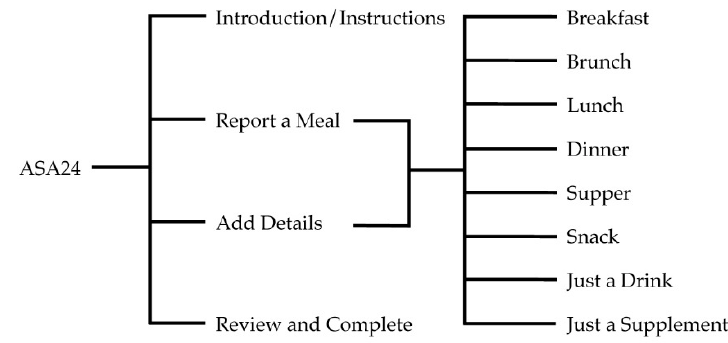
Figure 1. Participant tasks and sub-tasks while completing a dietary recall with the Automated Self-Administered Dietary Assessment Tool (ASA24).